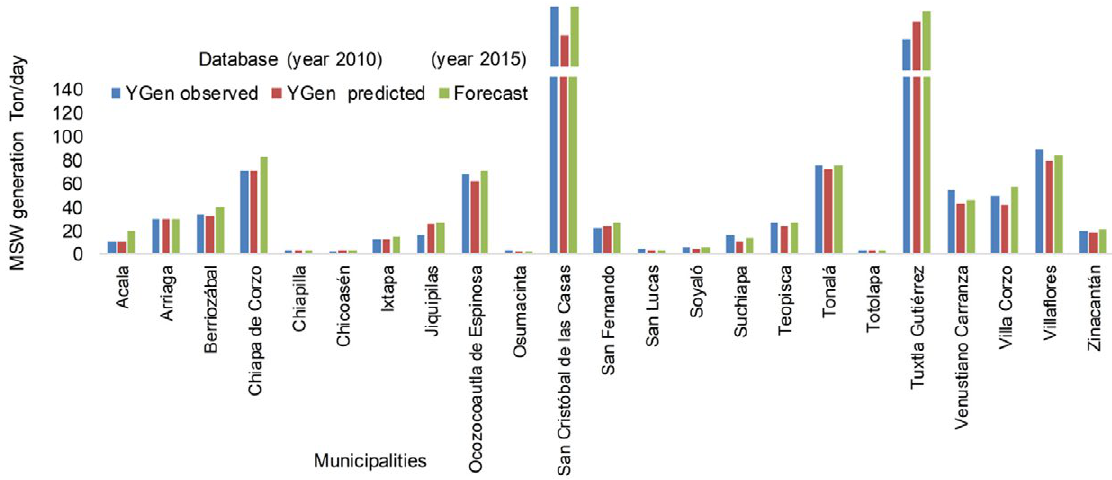
Fig. 5: Forecast of MSW generation rates in the municipalities of the study